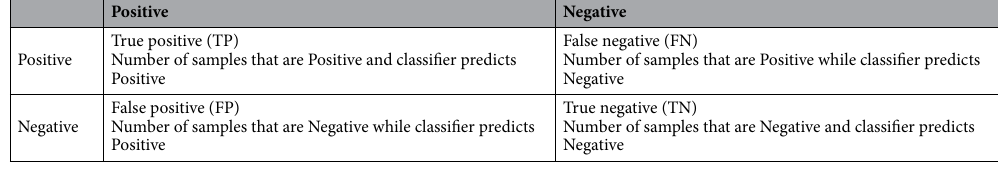
Table 4. Confusion matrix for a two-class problem.